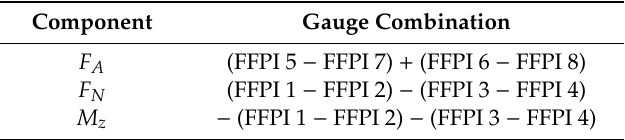
Table 2. Strain gauge combinations for the three aerodynamic loading components. FFPI—all-fiber Fabry–P é rot interferometric strain